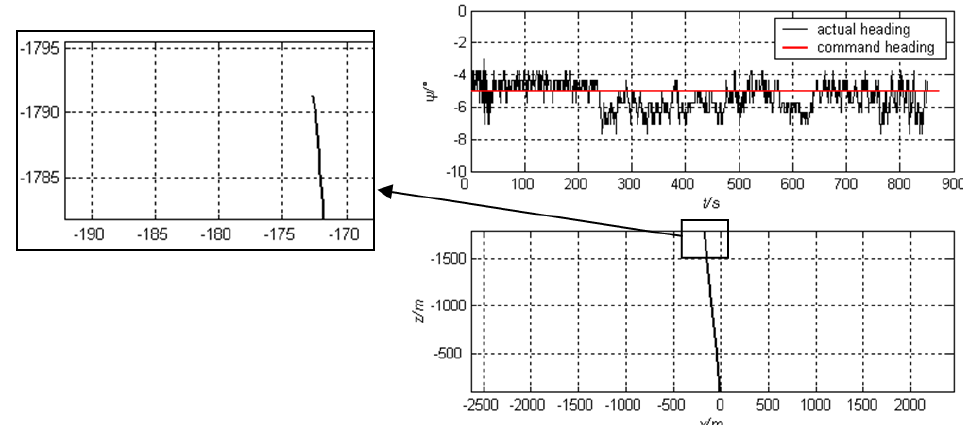
Figure 30. Heading keeping with −5°.